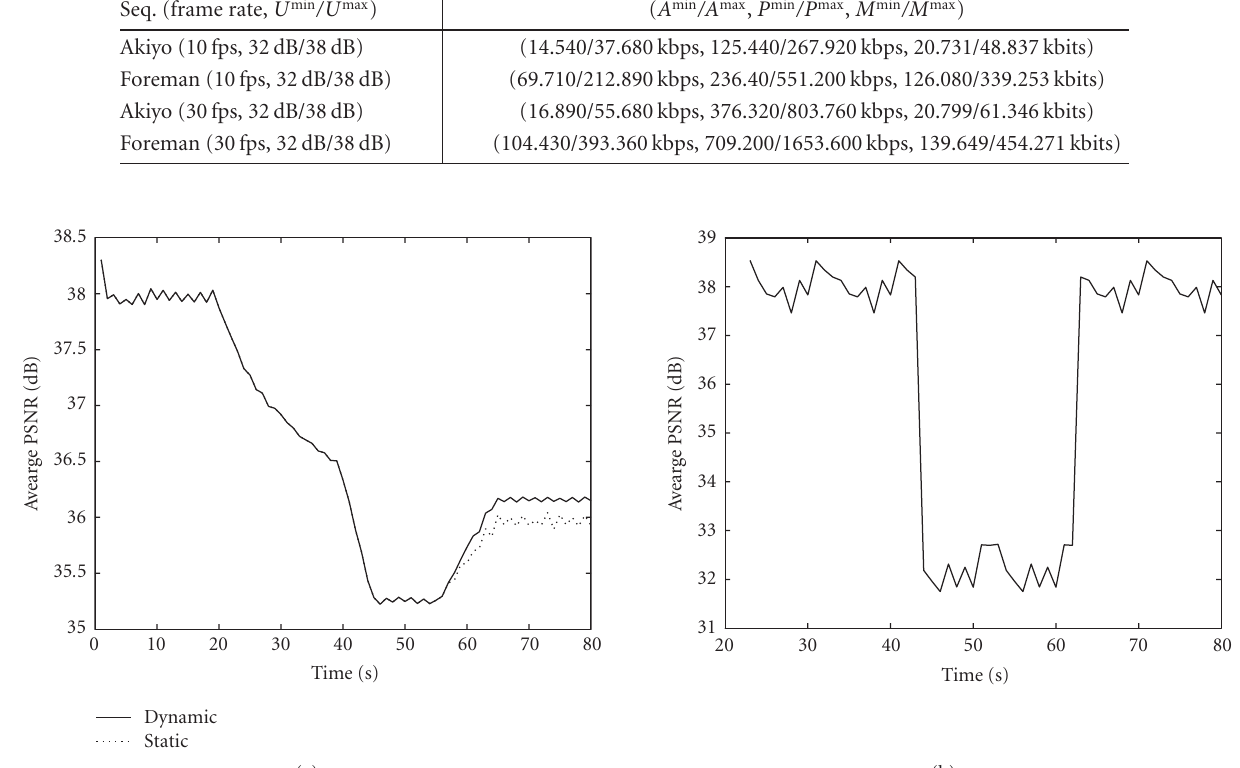
Table 1: The tra ffi c parameters for Akiyo and Foreman at di ff erent frame rates and di ff erent target PSNR values. Seq. (frame rate, U min /U max )